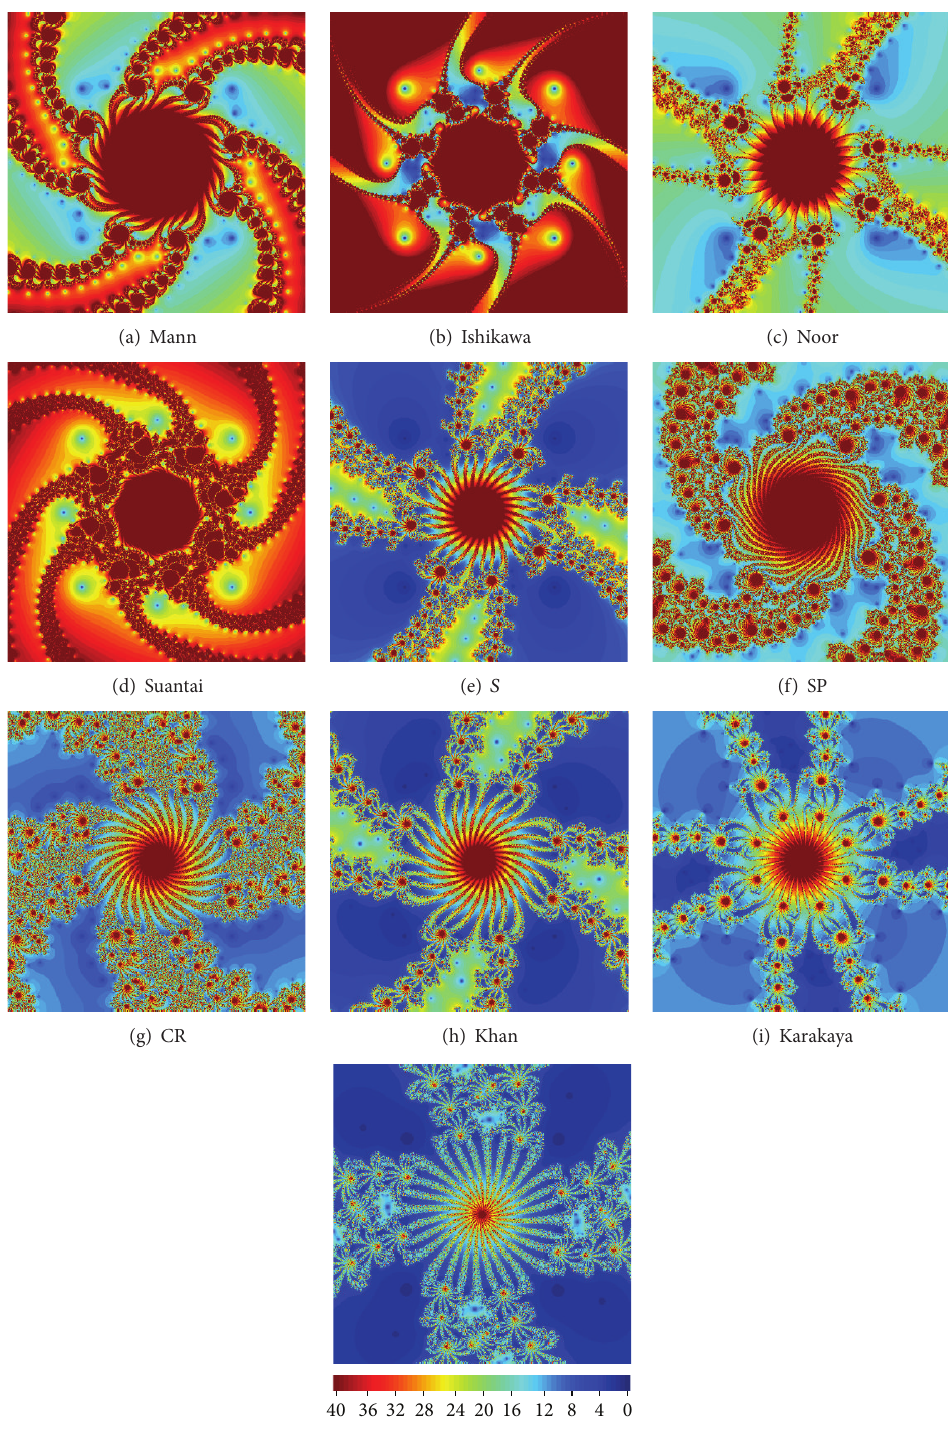
Figure 5: Examples of polynomiographs for 𝑝 1 with complex-valued parameters of